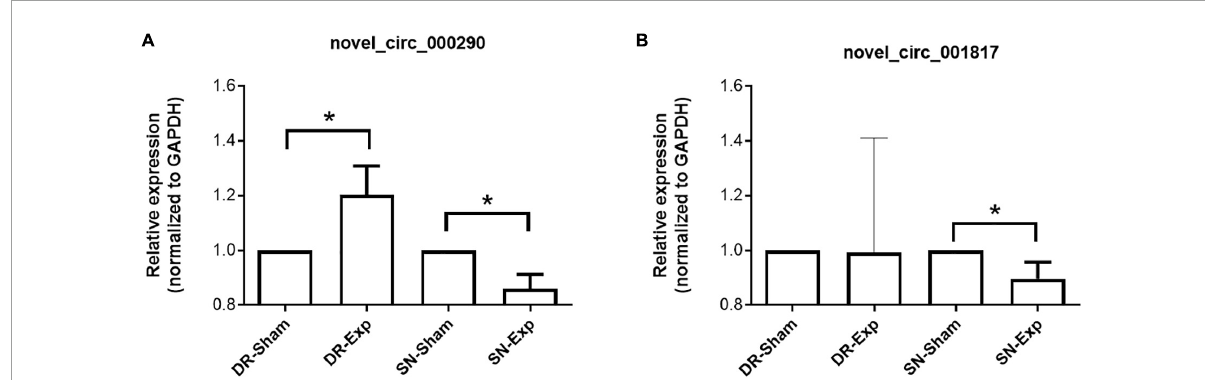
FIGURE3 Validation of the expression of differentially expressed circular RNAs after rat central and peripheral axon injuries. Relative expression levels of novel_circ_000290 (A) and novel_circ_001817 (B) after rat central and peripheral axon injuries. Data are summarized from 3 experiments and presented as mean with SEM. * P -value < 0.05.